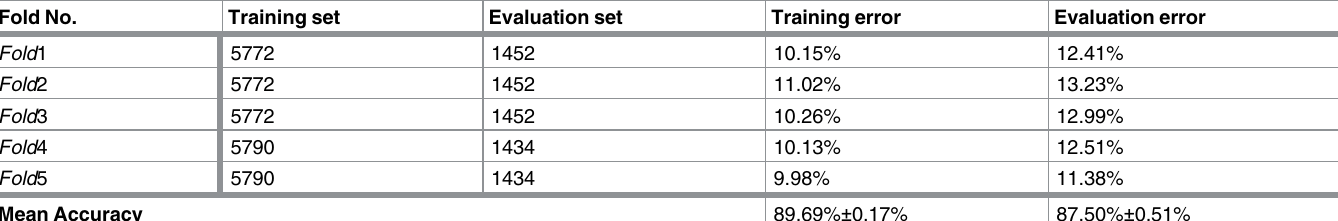
Table 4. 5-fold cross validation for 8 types of SCD RBC classification. Fold